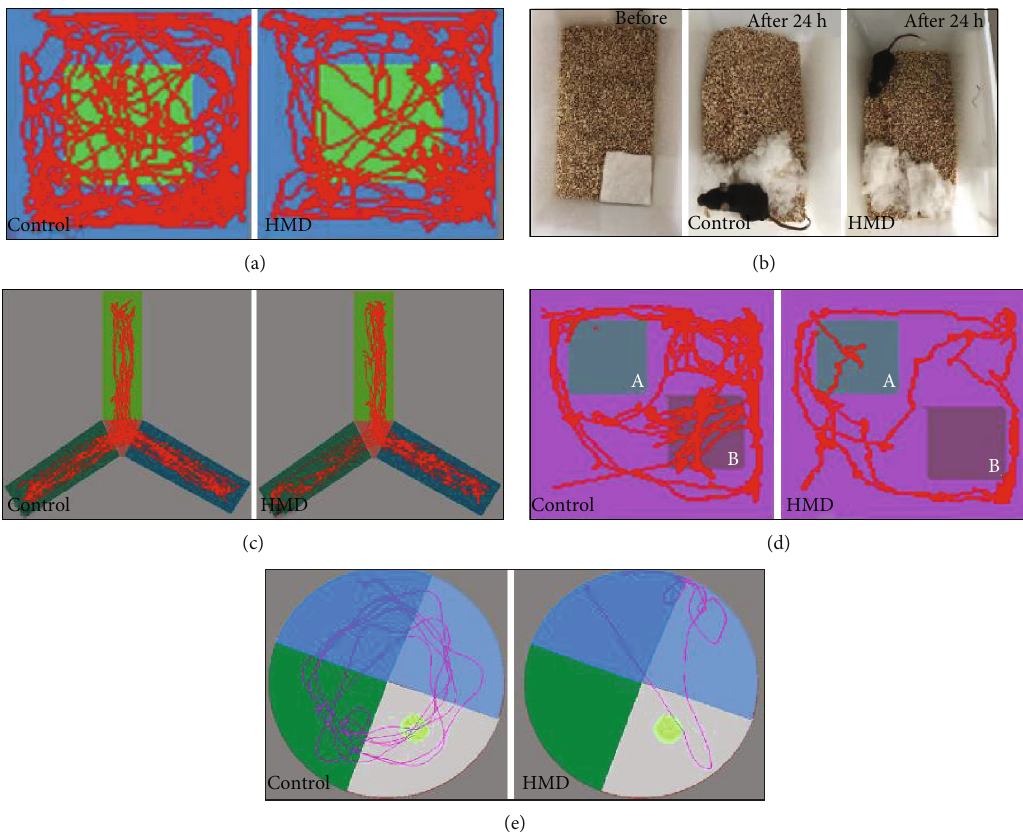
Figure 3: Representative photographs of behavioral test. (a) Representative tracing of open- fi eld test in each group. (b) Representative photographs of nesting test in each group. (c) Representative tracing of Y maze test in each group. (d) Representative tracing of new object recognition test in each group. (e) Representative tracing of Morris water maze test in each group.